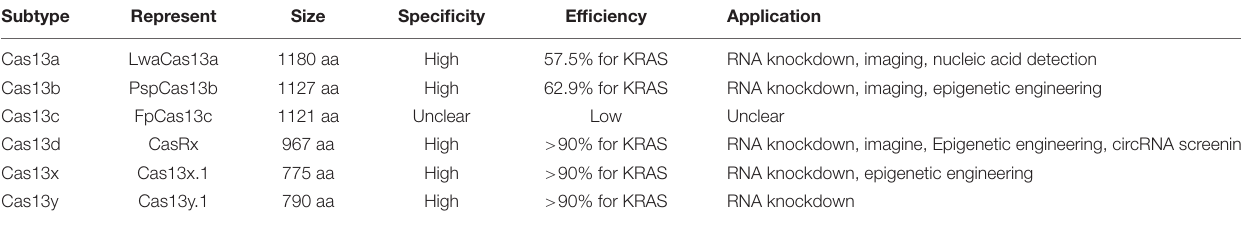
TABLE 1 | Major subtypes of Type-VI CRISPR/Cas system and their